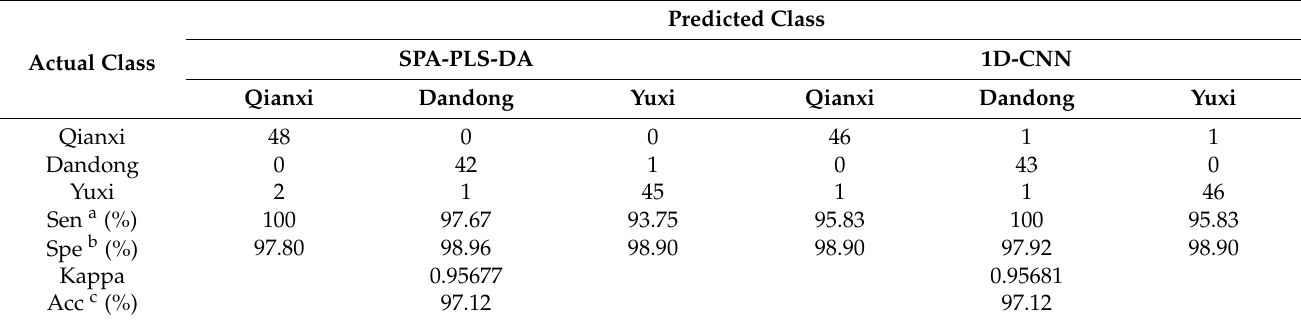
Table 8. Confusion matrix of the three sets predicted by SPA-PLS-DA and 1D-CNN models.